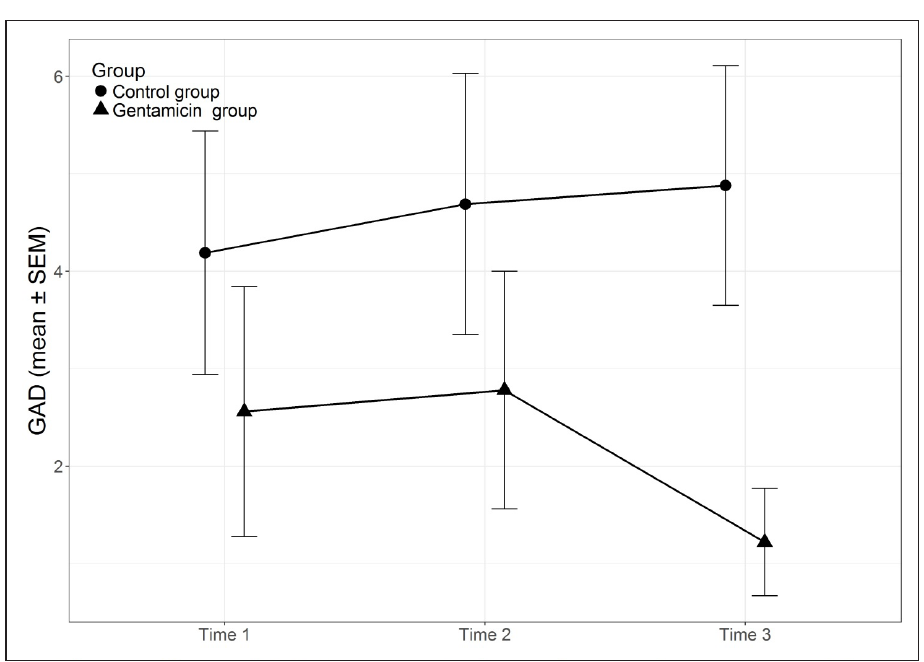
Fig. 1. Changes of GAD (mean ± standard error of mean) in the gentamicin and the control group during the study period. Time 1: 2 months before surgery, time 2: 2 weeks before surgery, after pretreatment in the genta- micin group, time 3: 3 months after surgery ( P =0.39).